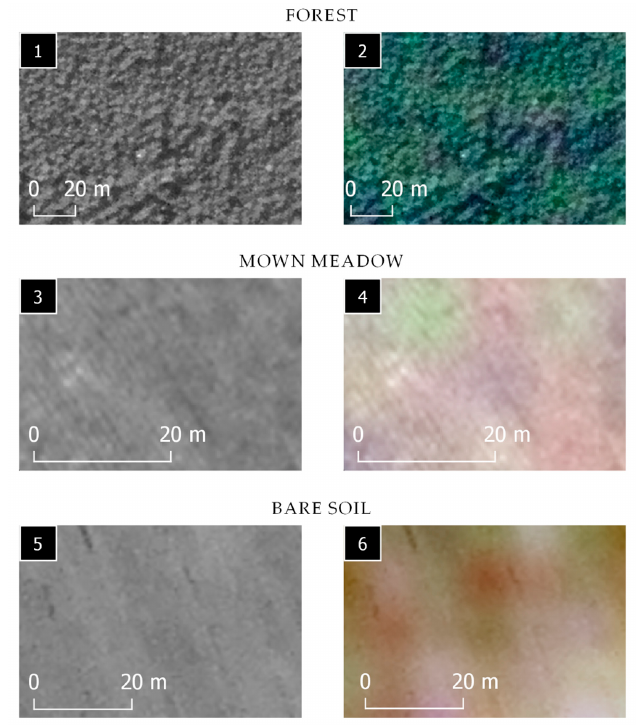
Figure A2. 1, 3, and 5—samples of the best high-spatial images; 2, 4, and 6—samples of images in natural color composition enhanced with the best high-spatial-resolution image.